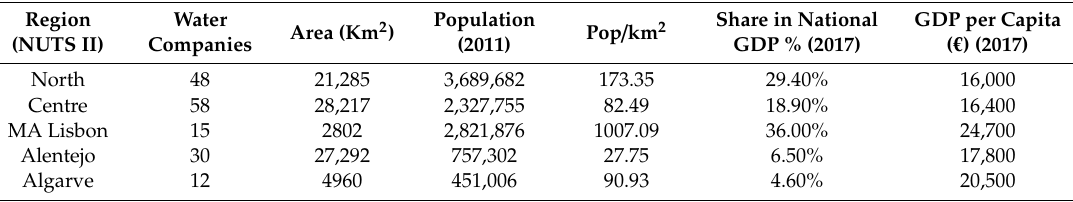
Table 2. Localization of the water companies and characteristics of the